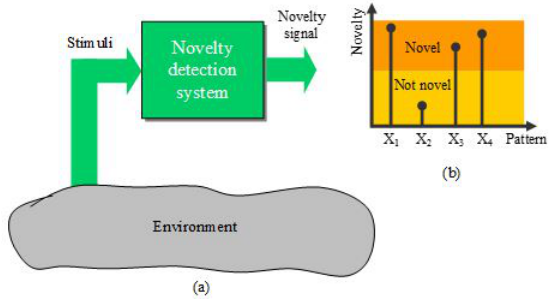
Figure 1: Novelty systems: (a) novelty signal as a function of stimuli; (b) discrete novel